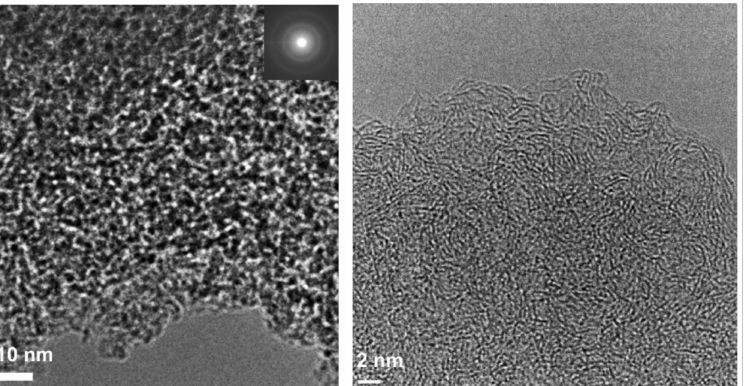
Figure 9. Nanoporous carbon fabricated from Lapsi seeds containing graphitic carbon structures with interconnected hierarchical micro- and